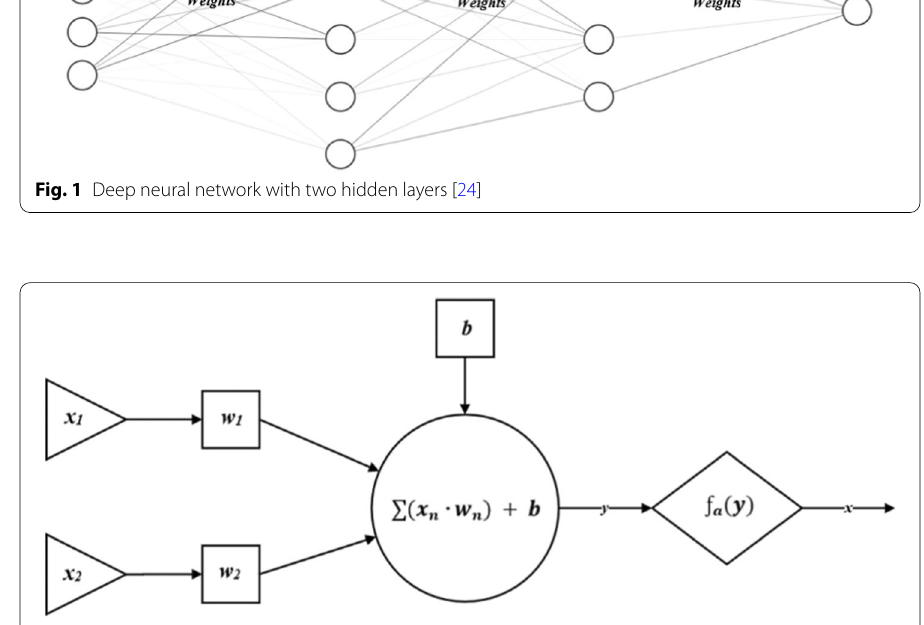
Fig. 2 Single artificial neuron with two